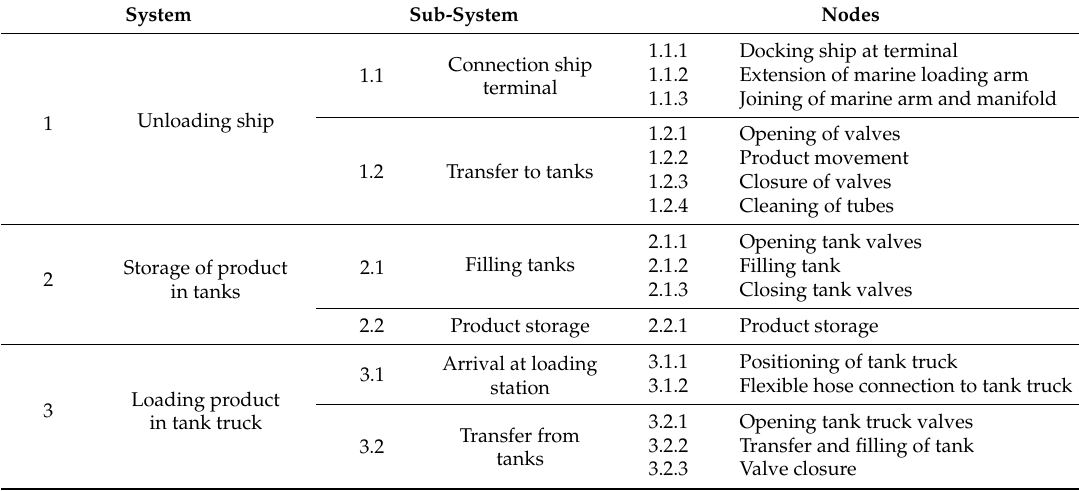
Table 4. Guide Words and Parameters used in the HAZOP analysis.